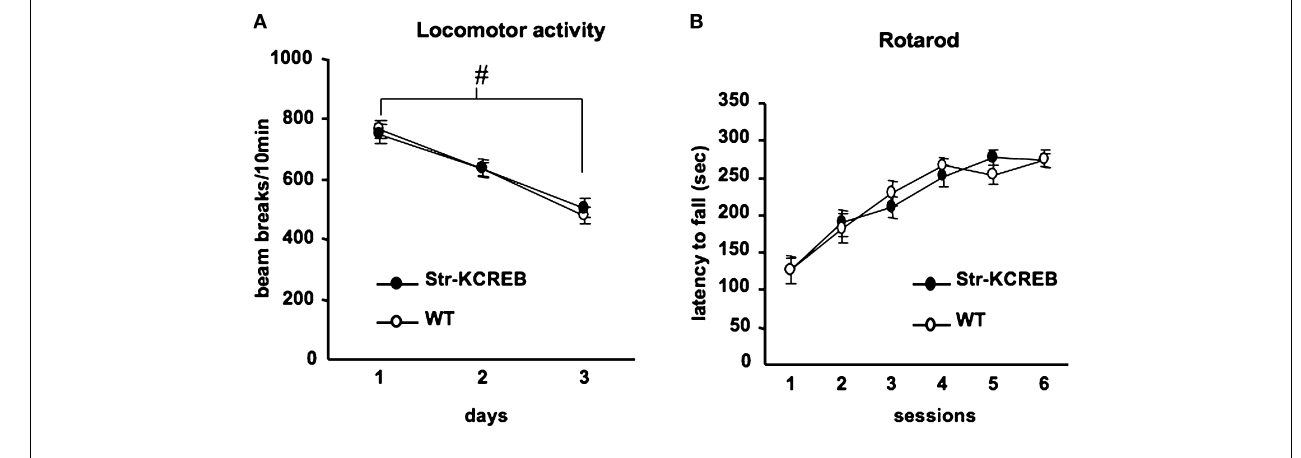
FIGURE 5 | Normal locomotor activity and coordination in str-KCREB mice. (A) Transgenics and littermate controls ( n = 40,40) were examined for locomotor behavior in activity boxes. str-KCREB mice and wild-type controls were monitored in activity boxes equipped with infrared photocell beams (10 min exploratory sessions on three consecutive days). str-KCREB mice habituated normally to the test environment, manifesting a signifi cant decrease in spontaneous